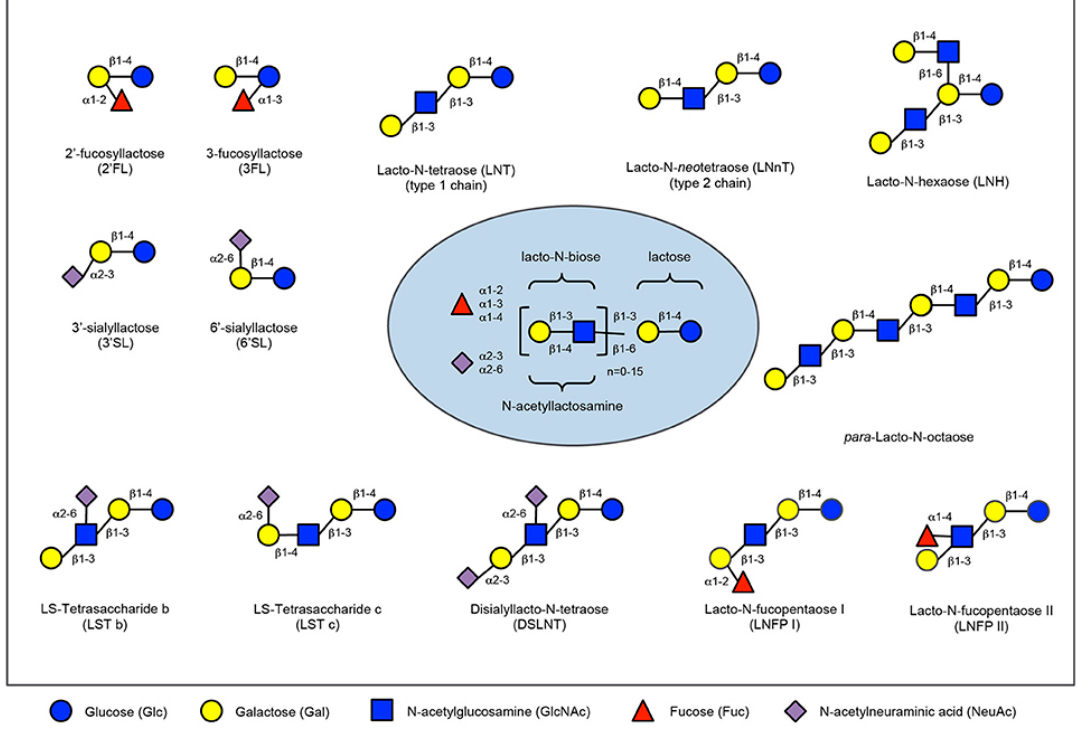
Figure 2. Human milk oligosaccharide composition blueprint.